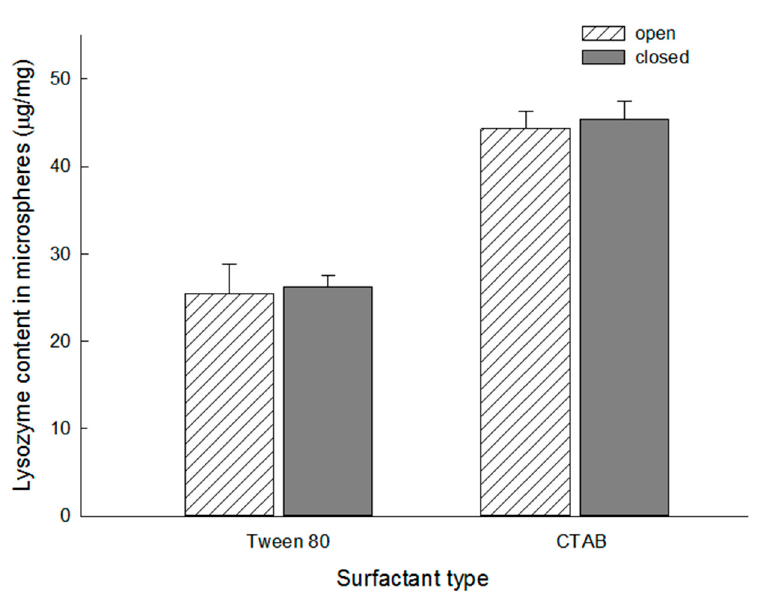
Figure 9. Effect of surfactant type upon lysozyme payloads in PLGA microspheres before and after pore closure. Dried microspheres prepared using 3 mL of the ammonia solution were first incubated in a 100 mg/mL lysozyme solution containing 0.2% either Tween 80 or CTAB (RT/2 h), and self-sealing (41 °C/2 h) was carried out. Lysozyme contents in microspheres before and after self-healing were determined.